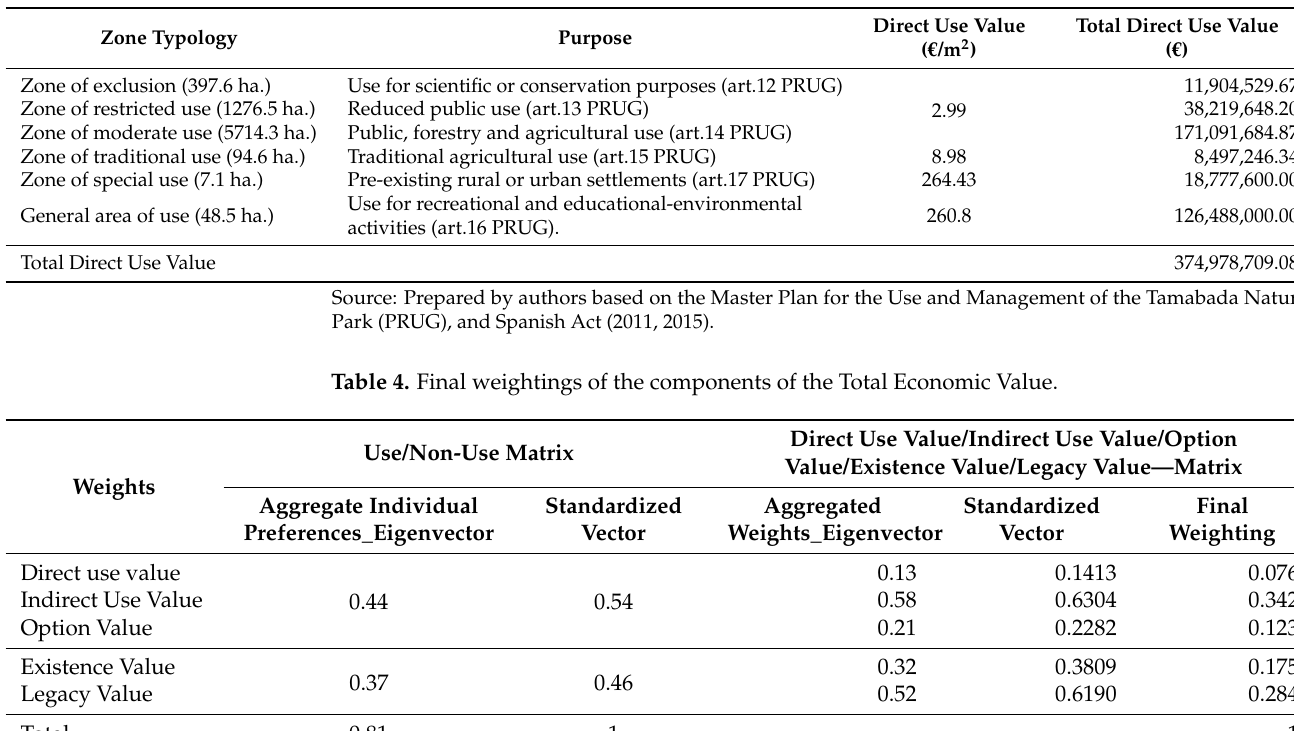
Table 3. Valuation of direct use (Euro 2019).